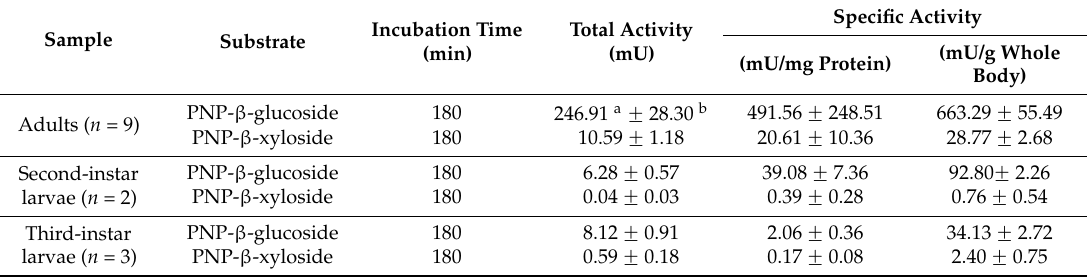
Table 1. Glycosidase activities in whole bodies of Cylindrocaulus patalis .